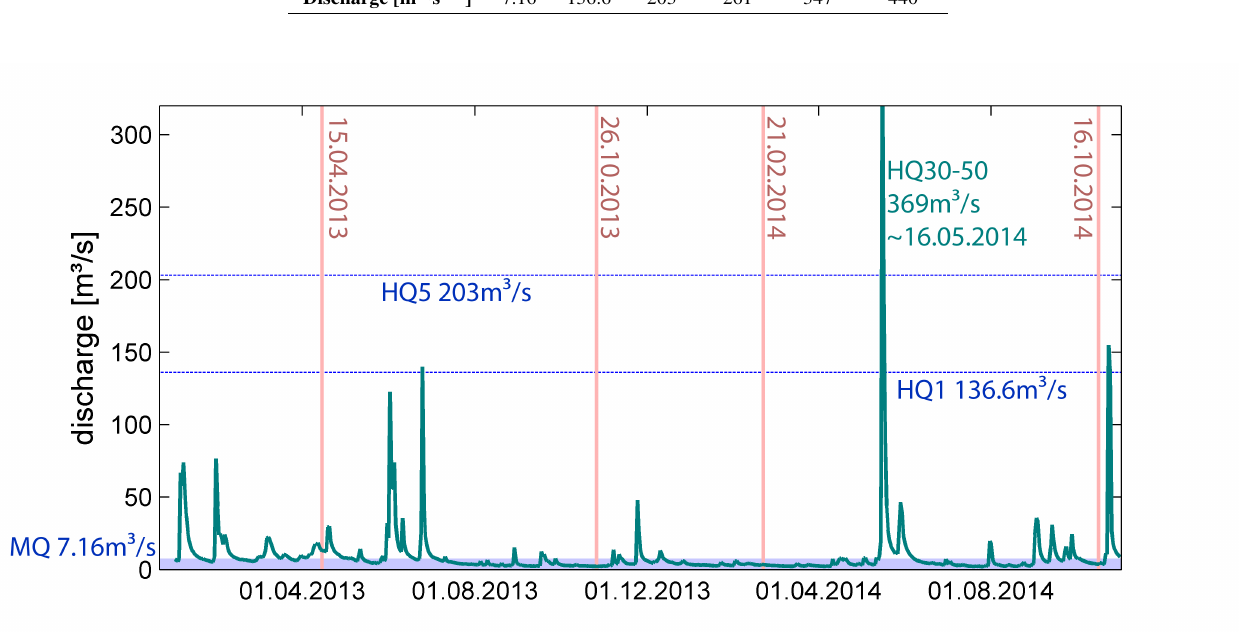
Figure 2. Discharge of Pielach River at Loosdorf 2013–2014 obtained from combining the discharges at gauging stations Hofstetten (Pielach) and Sierningbach; vertical red lines: flight dates; horizontal black lines: characteristic